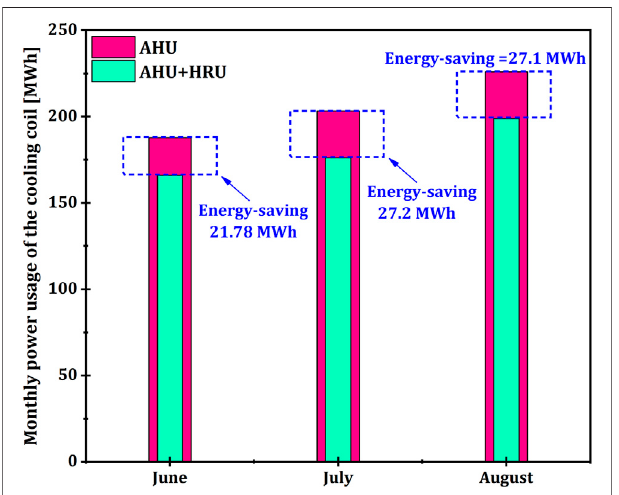
FIGURE 8 | The monthly power demand of the cooling coil.